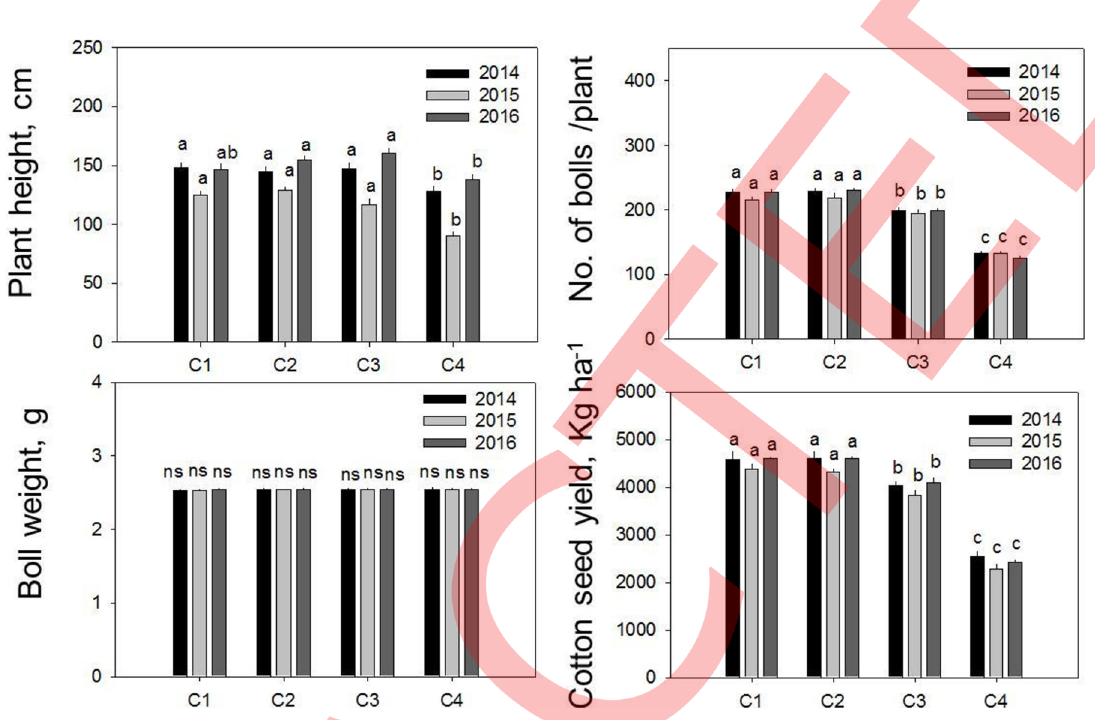
Fig 3. Plant height, seed cotton yield and related traits of cotton sown under different planting techniques. In X-axis legend, C 1 = cotton grown as sole crop, C 2 = relay cropped cotton in wheat (75 cm apart rows), C 3 = relay cropped cotton in wheat (150 cm apart rows) and C 4 = cotton planting after wheat